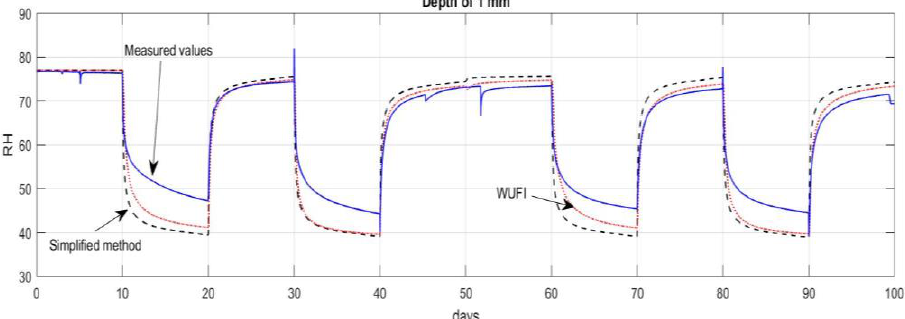
Figure 1. The results at 1 mm depth of the calculated RH in comparison with the measured data. The blue solid line indicates the measured data, the black dotted line is the simulation by WUFI ® Pro and the red dashed line the Simplified model. Geosciences 2018 , 8 , x FOR PEER REVIEW